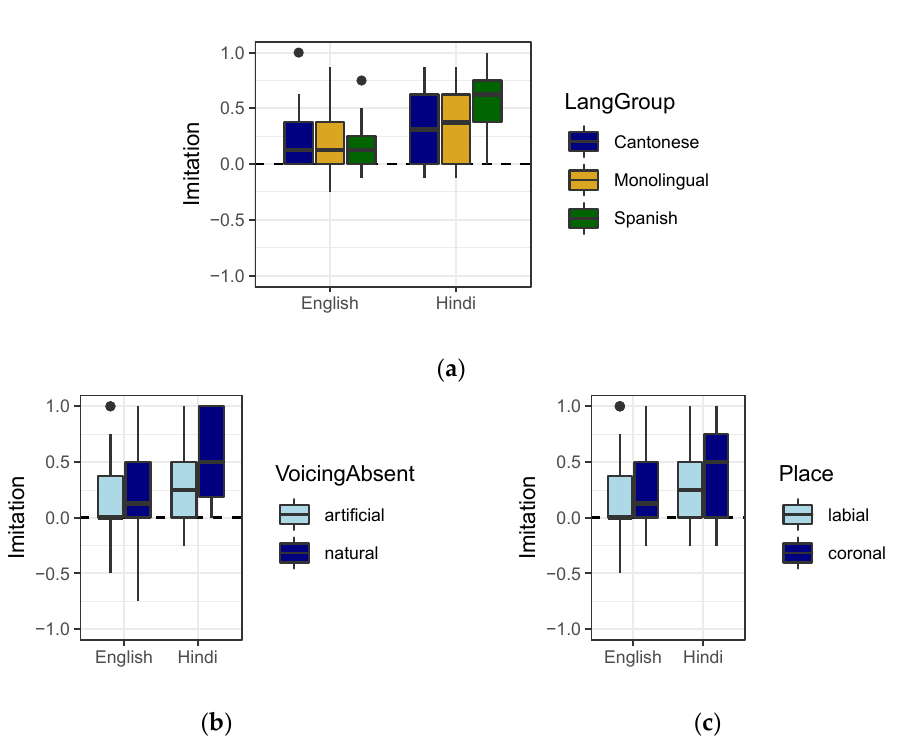
Figure 4. Distribution of by ‐ participant imitation scores across ( a ) Language Groups, ( b ) artificial vs. natural VoicingAbsent conditions, and ( c ) Places of Articulation. Imitation scores represent the difference in proportion of prevoiced tokens when imitating stimuli where prevoicing is present vs. absent; values of 1 indicate completely faithful imitation. Table 5. Statistical results for the imitation task. Effects in bold are significant ( p < 0.05).